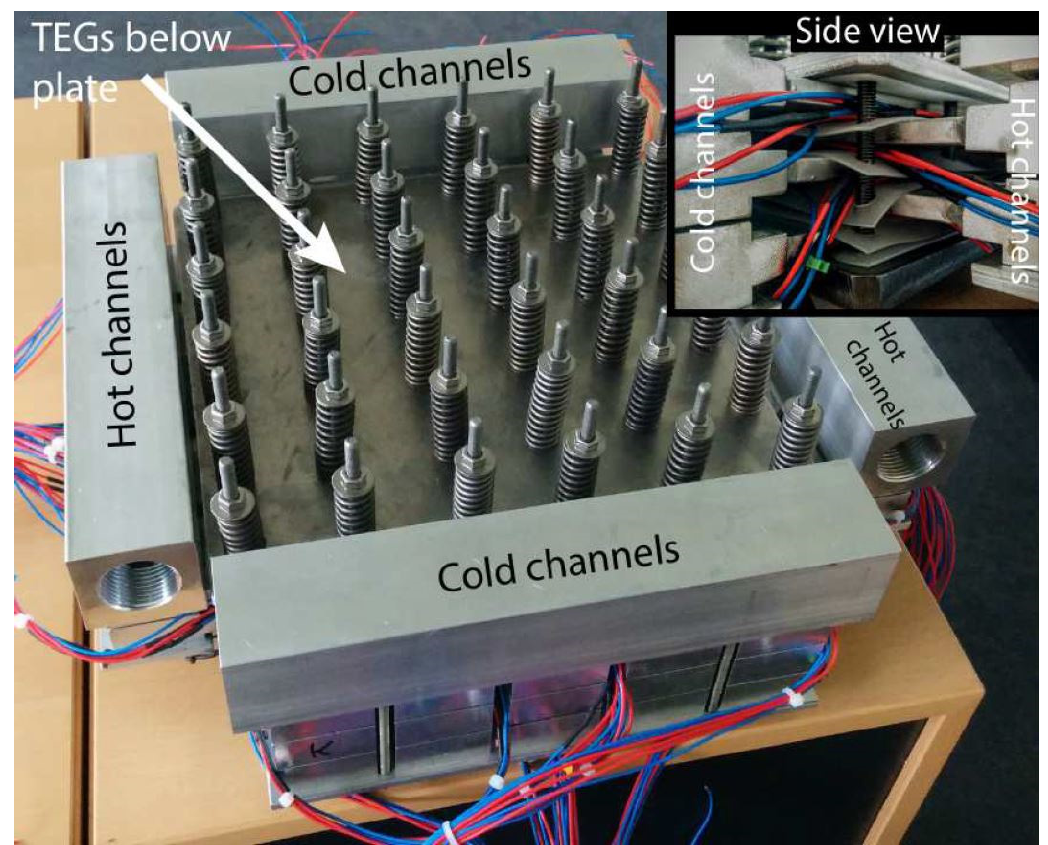
Figure 22. Experimental setup of a fluid-fluid TEG system with fins in the channels and 100 TEGs. Reprint with permission [95]; Copyright 2021, Elsevier.